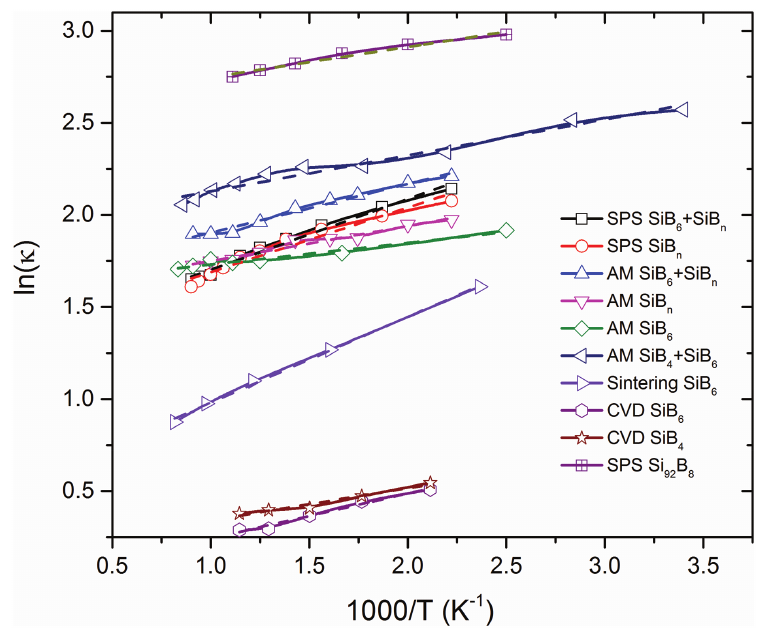
Figure 9: A semi-log (Arrhenius-type) plot of ln k versus T − 1